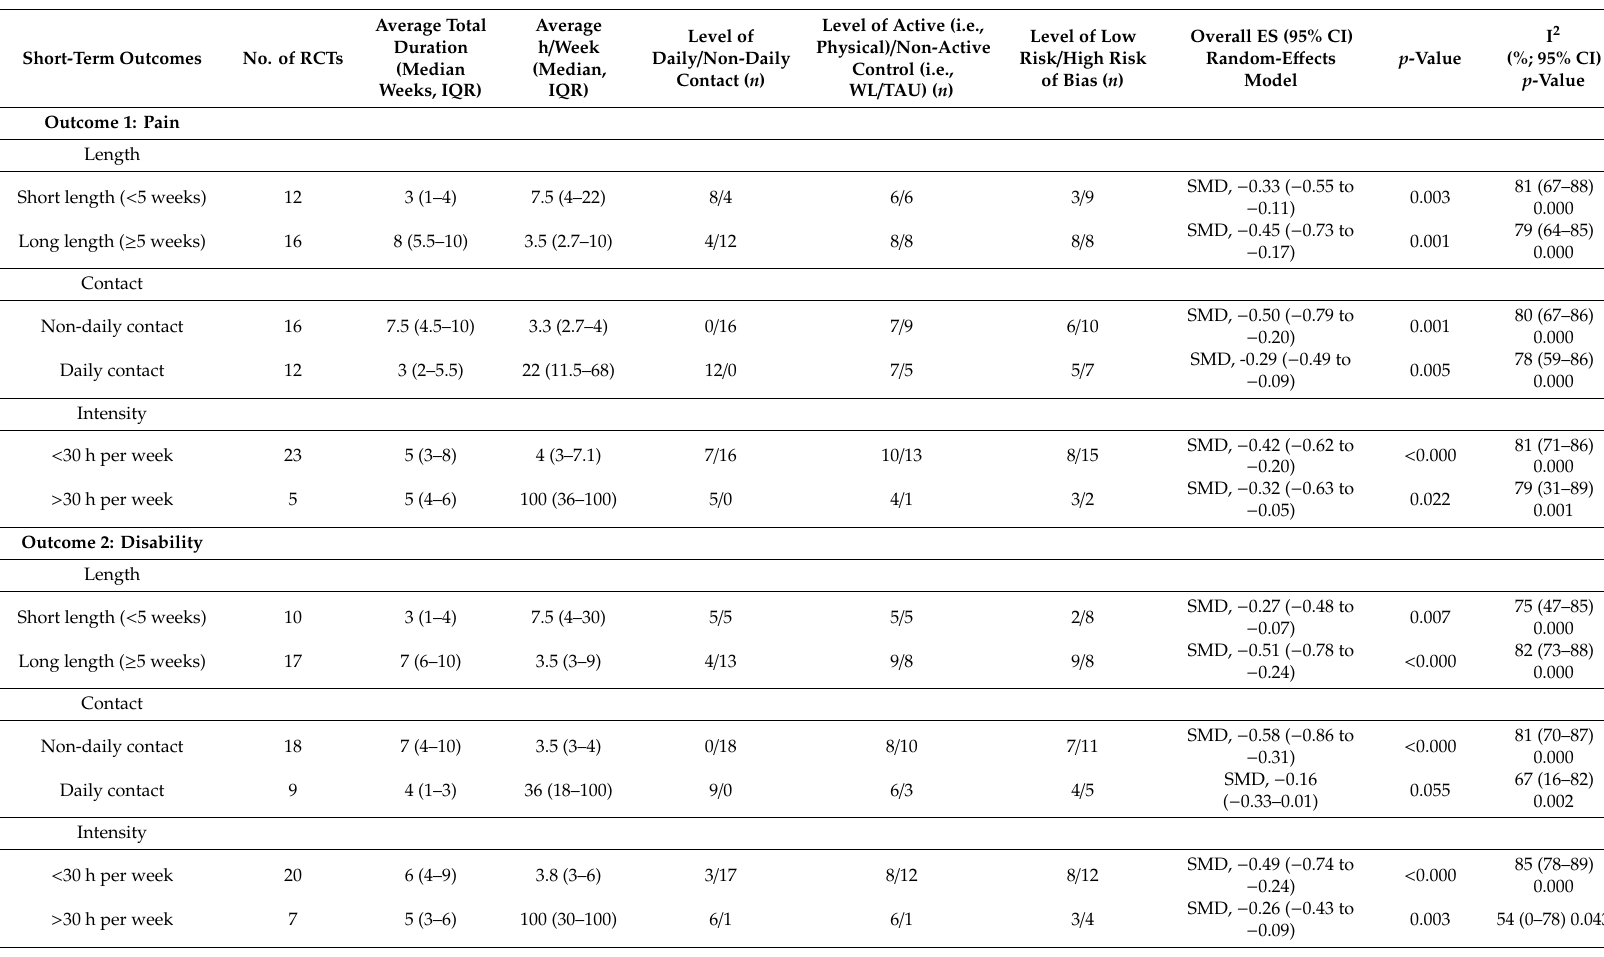
Table 2. Characteristics and subgroup meta-analysis for dose of IMPT by length, contact, and intensity of the six investigated